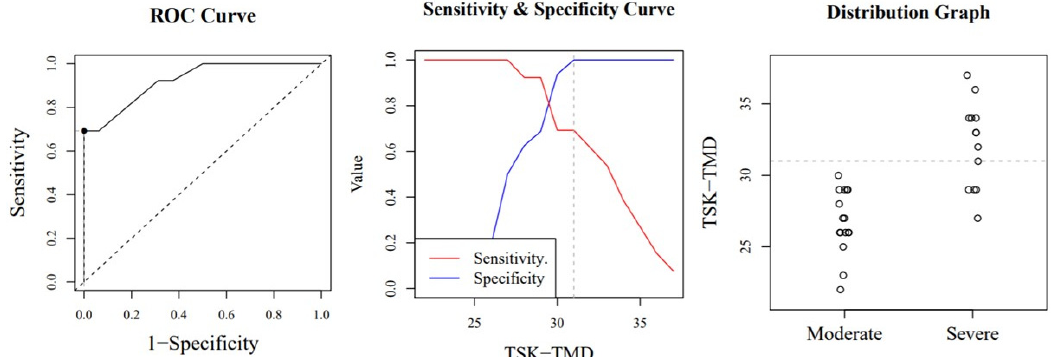
Figure A3. Optimal cut-off point between levels of jaw kinesiophobia. The image shows a ROC (Receiver Operating Characteristic) curve that represents the sensitivity of a diagnostic test that produces continuous results, depending on false positives (complementary to specificity), for different cut-off points (image on the left ), the image where the cut-off point at which the highest sensitivity and specificity is achieved (image in the middle ) and finally, a moderate and severe sample distribution graph (image on the right ).